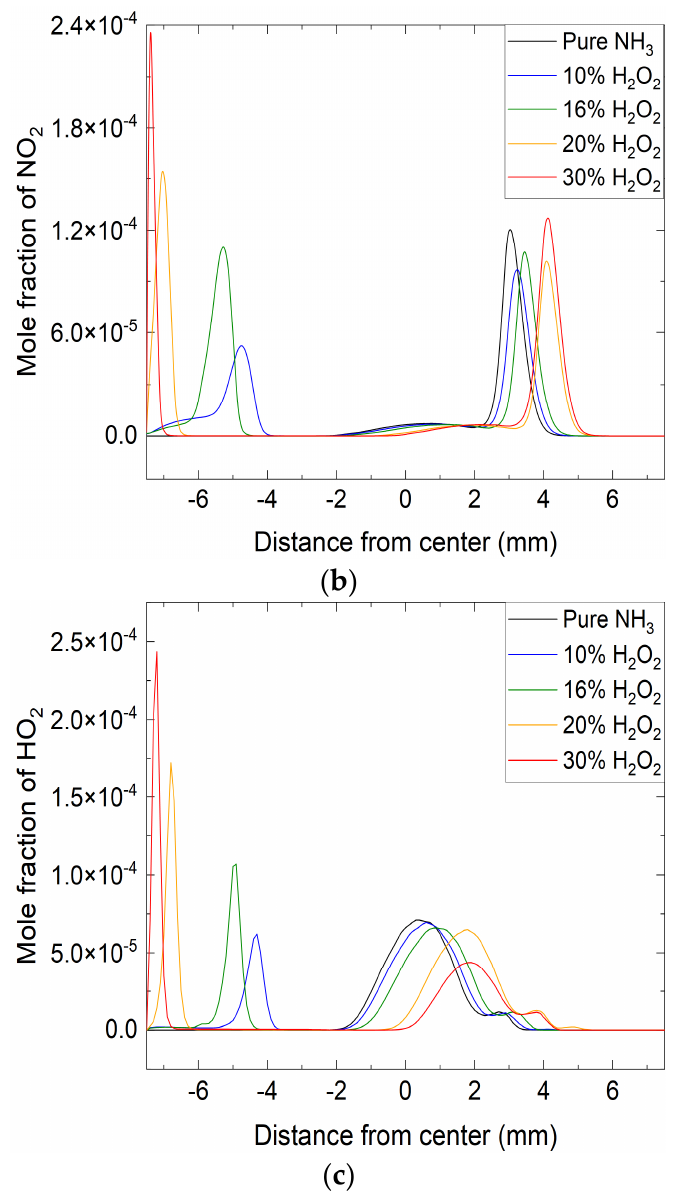
Figure 8. NO ( a ), NO 2 ( b ), and HO 2 ( c ), mole fraction distributions along the burner center line. Contrary to HO 2 , H and OH only form in the high-temperature zone of the non- premixed combustion with oxygen and they are absent from the zone of relatively low temperature premixed reaction of NH 3 with H 2 O 2 , as shown in Figure 9. Following closely the location of maximum temperature (see Figure 2), the location of maximum mole fraction for these two radicals moves closer to the O 2 -nozzle with increasing H 2 O 2 addition. The peak values of the mass fractions of these radicals decreases with increasing H 2 O 2 content in the fuel stream because less fuel is available for combustion in the non-premixed flame, which leads to reduced heat release and maximum flame temperatures, as shown in Figure